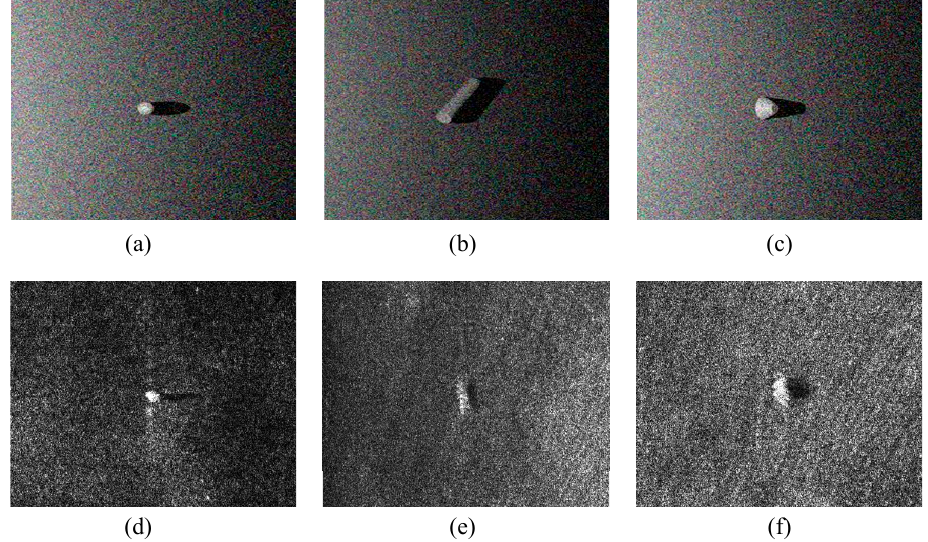
Figure 6. Image of experimental dataset. ( a ) Simulated sphere object. ( b ) Simulated cylinder object. ( c ) Simulated truncated cone object. ( d ) Real sphere object. ( e ) Real cylinder object. ( f ) Real truncated cone object.